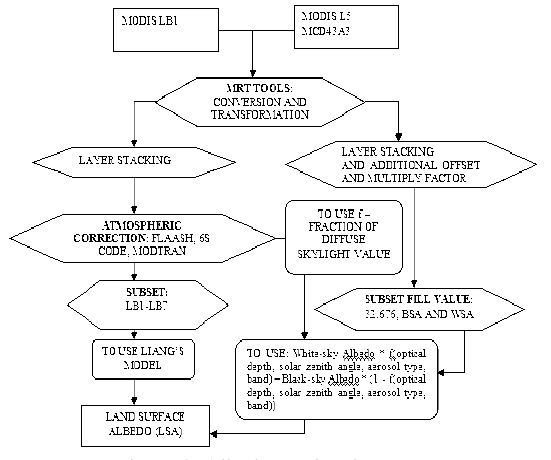
Figure 2. Albedo Retrieval Processes